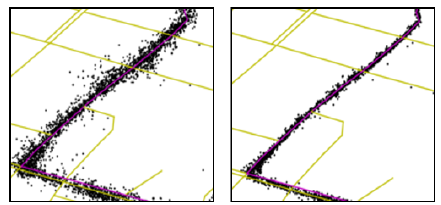
Figure 1. GPS trajectory data of two buses on the same